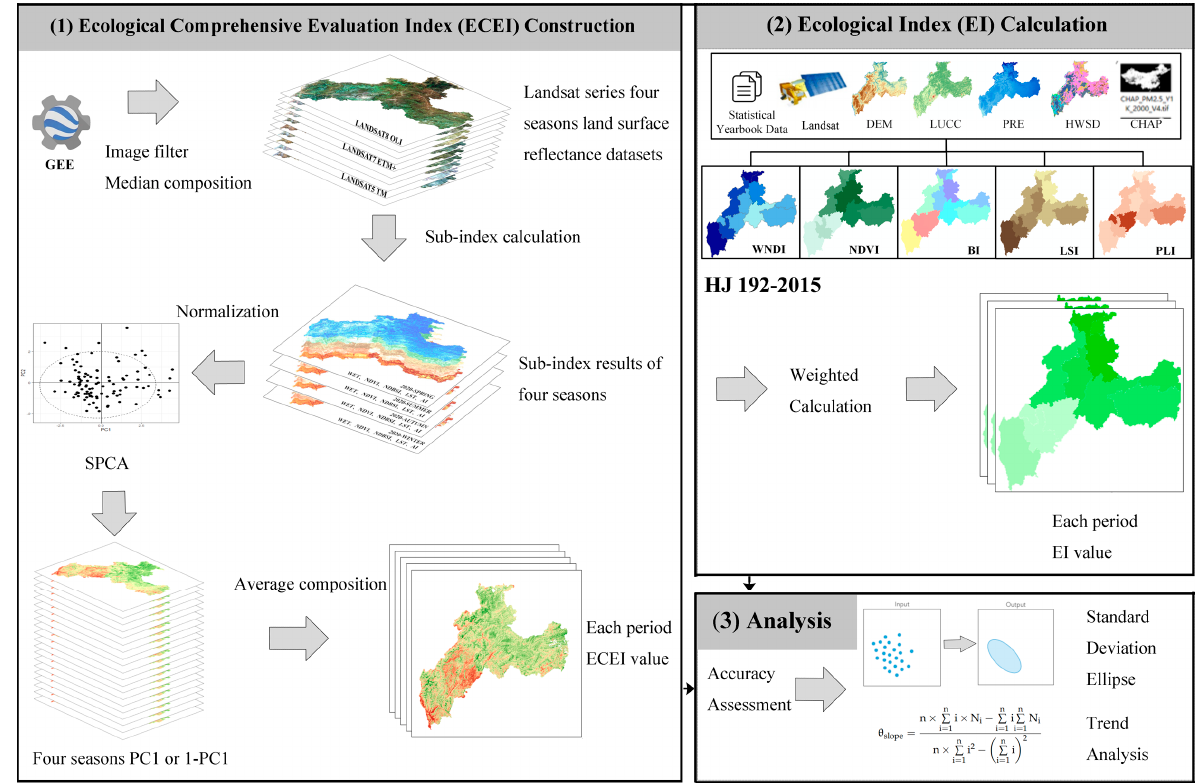
Figure 2. Framework of this